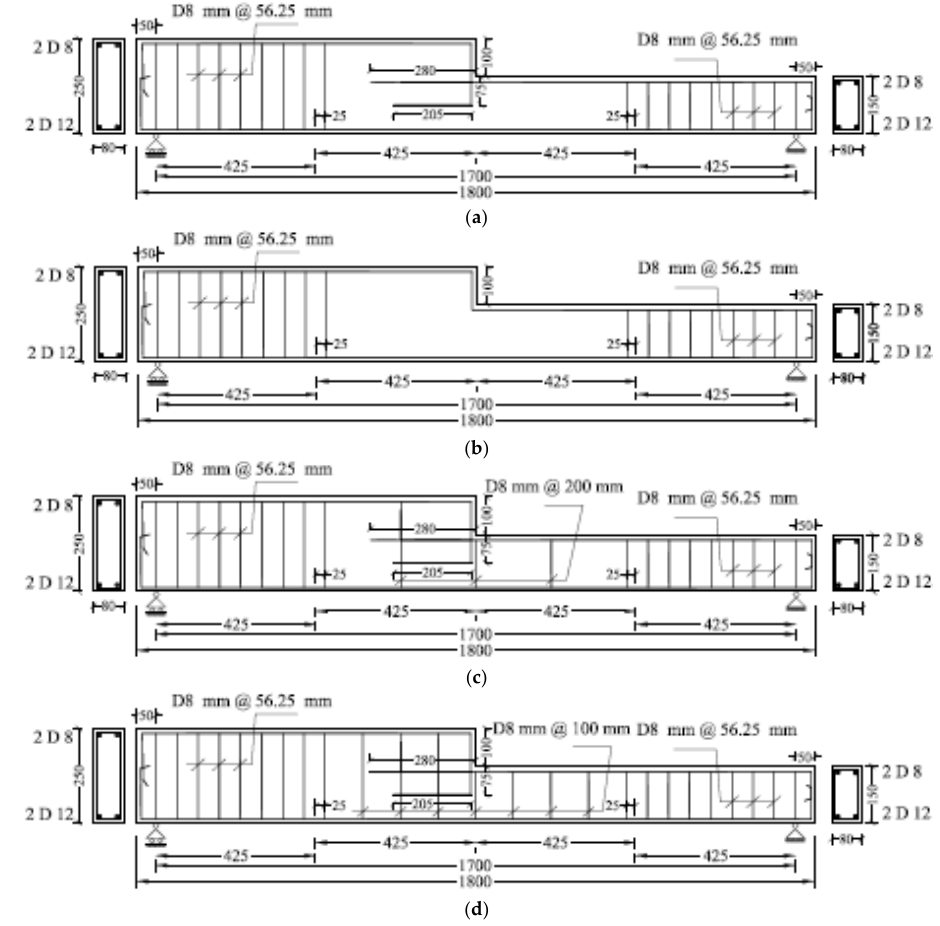
Figure 4. Details of the tested specimens of group G2: ( a ) B1 *, ( b ) B2 *, ( c ) B3 *, and ( d ) B4 *. The 1700 mm loaded span was divided into four identical distances (425 mm), each two were positioned at half of the span. The depth of each half span was either 250 mm or 150 mm. Each half span had two equal lengths (each one = 425 mm), one of which was a shear span and the other a pure bending moment. The stirrups were made to avoid shear failure during shear span. The stirrups’ amount was changed for the 425 mm bending moment portion either at large depth (250 mm) or at small depth (150 mm). For the